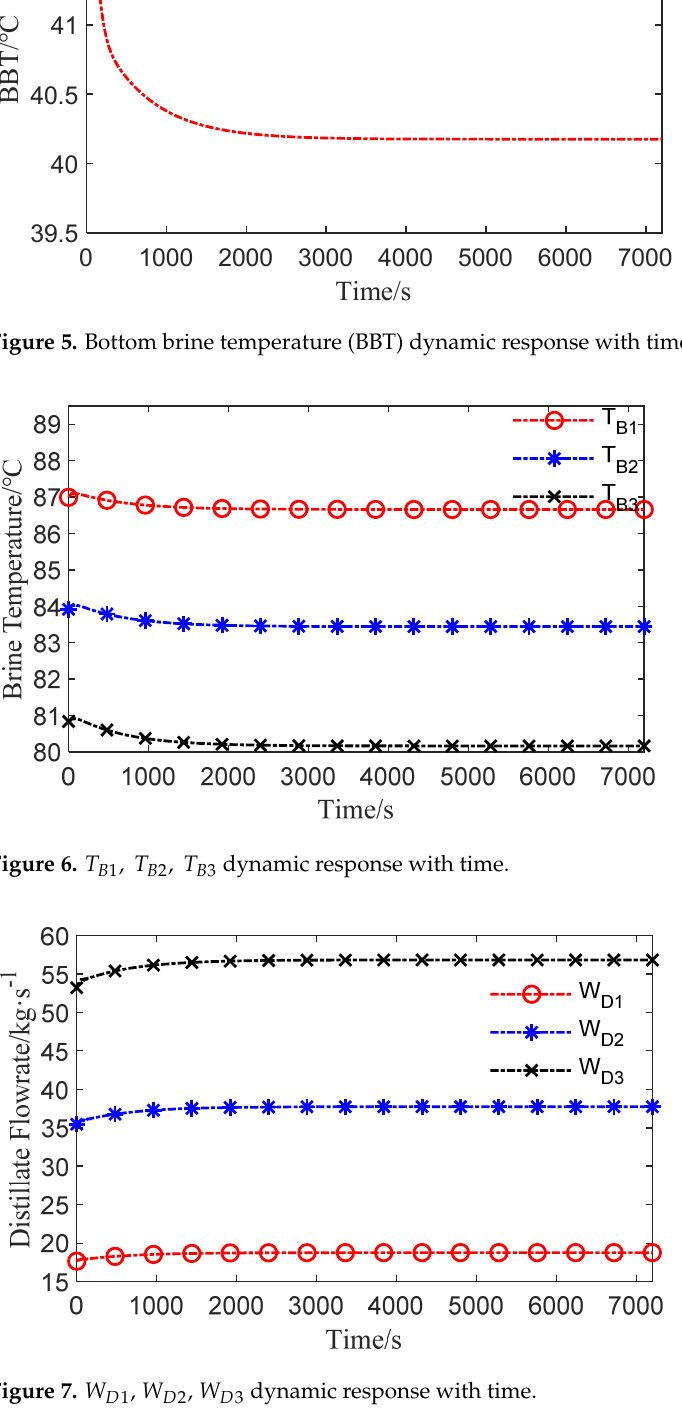
Figure 7. W dynamic response with time. Figure 7. W D 1 , W D 2 , W D 3 dynamic response with